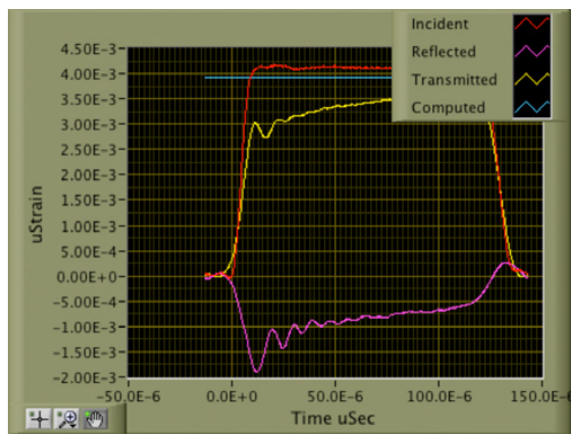
Fig. 8. HSR test result of Stress-Proof. Impact velocity of 37.3 m / s.